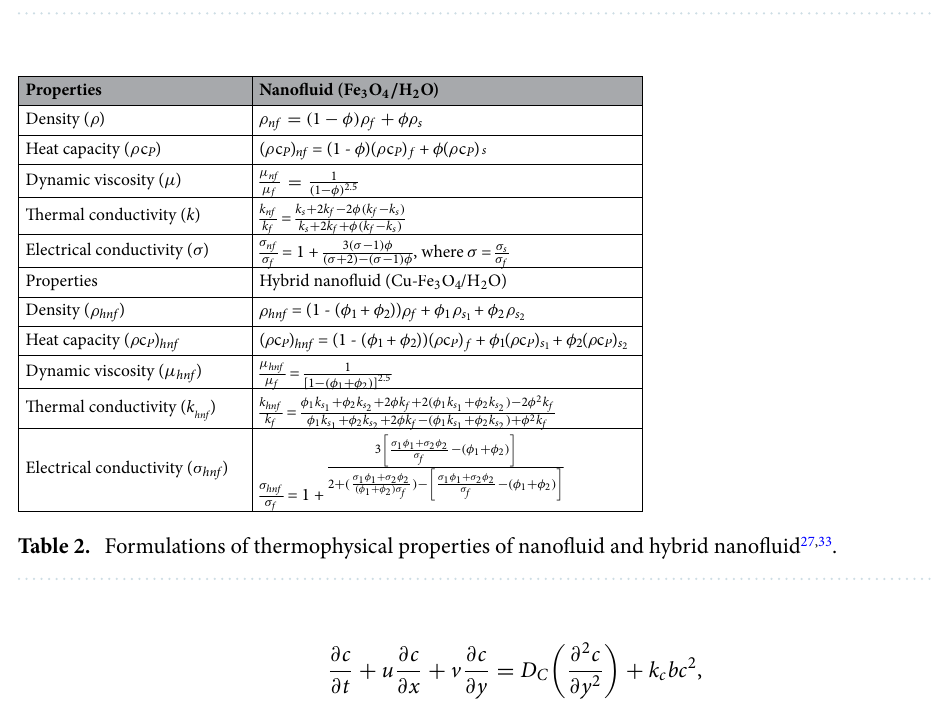
Table 1. Thermophysical properties of water and nanoparticles 3 .